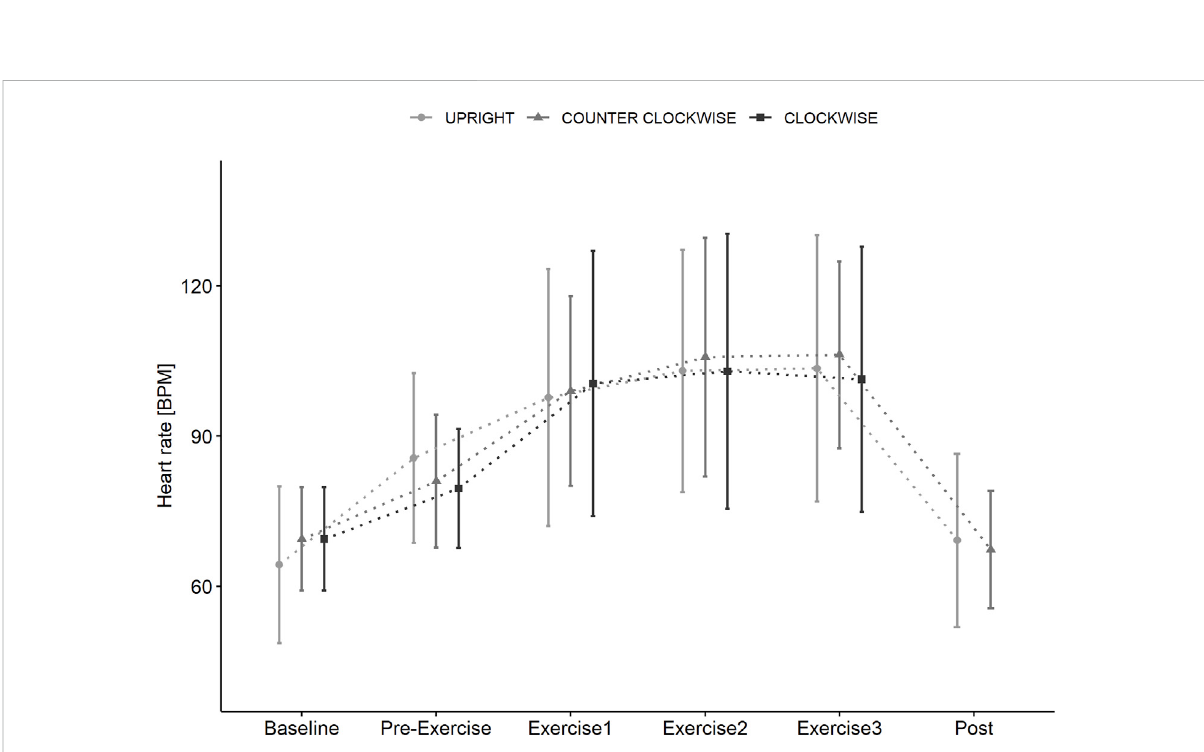
FIGURE 4 Heart rate (bpm) in supine position (BASELINE) prior to standing (PRE-EXERCISE) in the UPRIGHT condition, and when passively rotated (PRE- EXERCISE) clockwise (CLOCKWISE) and counter-clockwise (COUNTER-CLOCKWISE) with 1 g at the participants center of mass in addition to directly following Contra-lateral,WoodChopper and Crunch exercise (BREAK 1,BREAK 2, BREAK 3) and upon completion (POST) of each condition. Data as mean